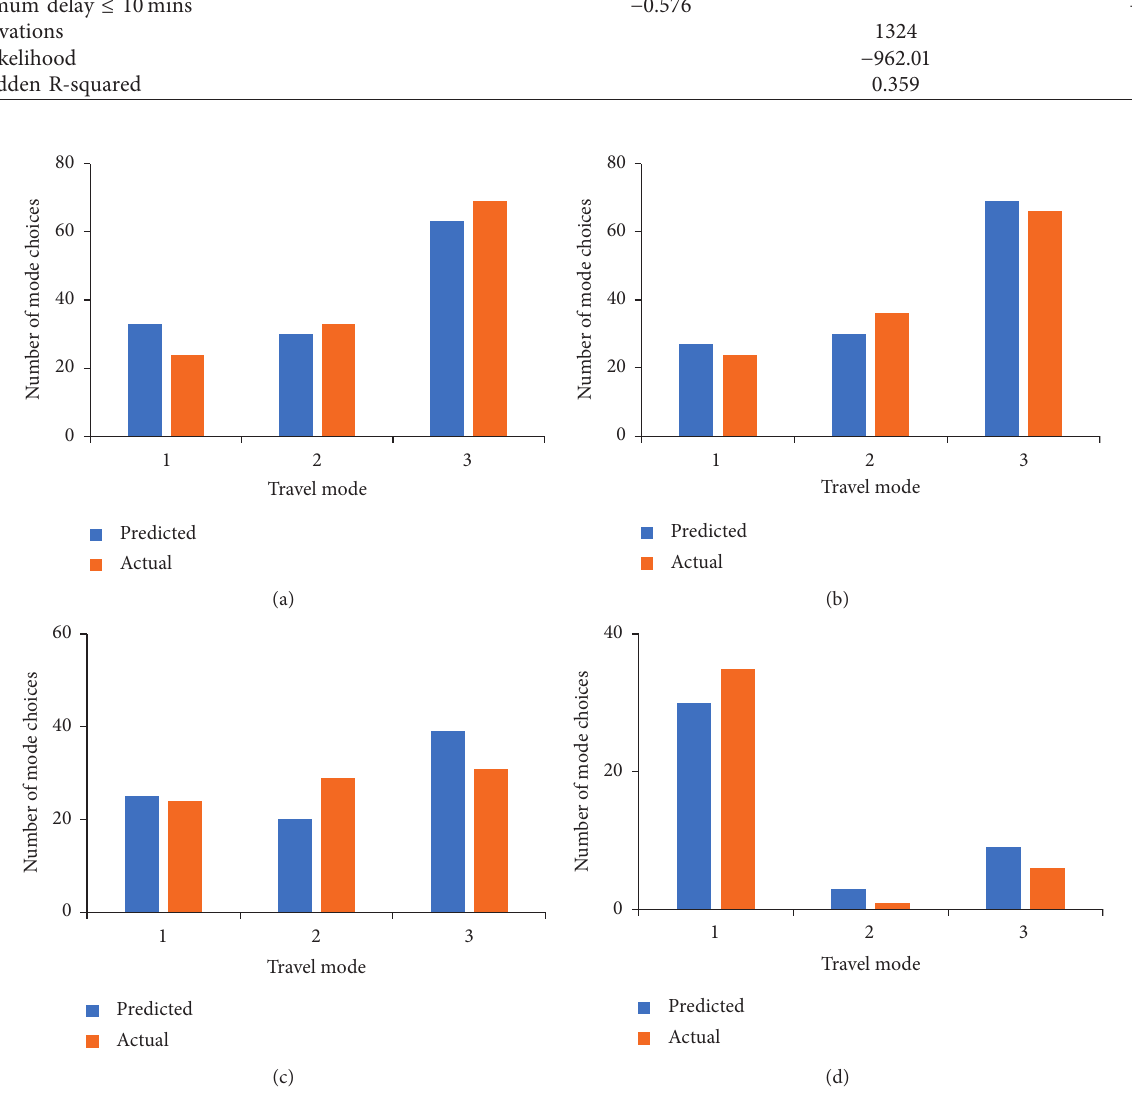
Figure 2: Comparison of predicted and observed numbers of mode choice. (a) Income 1. (b) Income 2. (c) Income 3. (d) Income